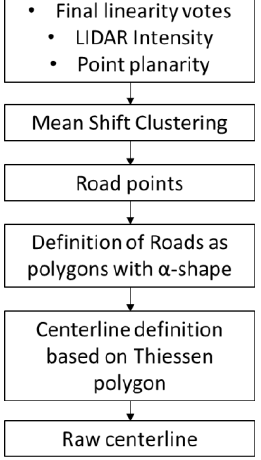
Figure 4. Workflow for raw centreline